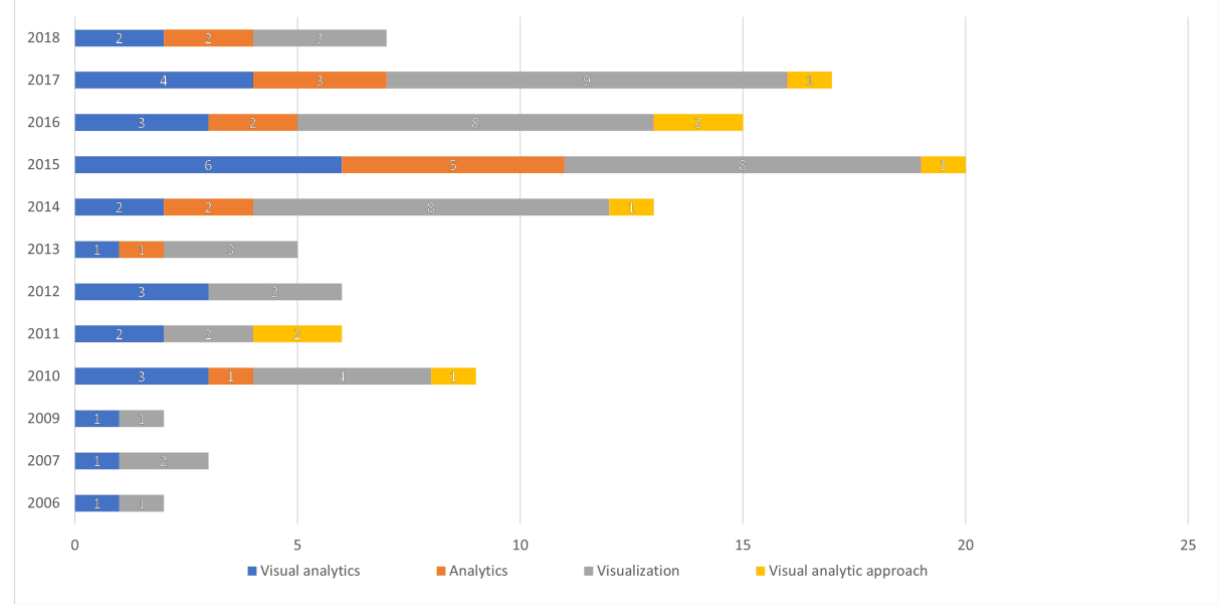
Figure 4. Use of terminology from January 01, 2005, to March 30,